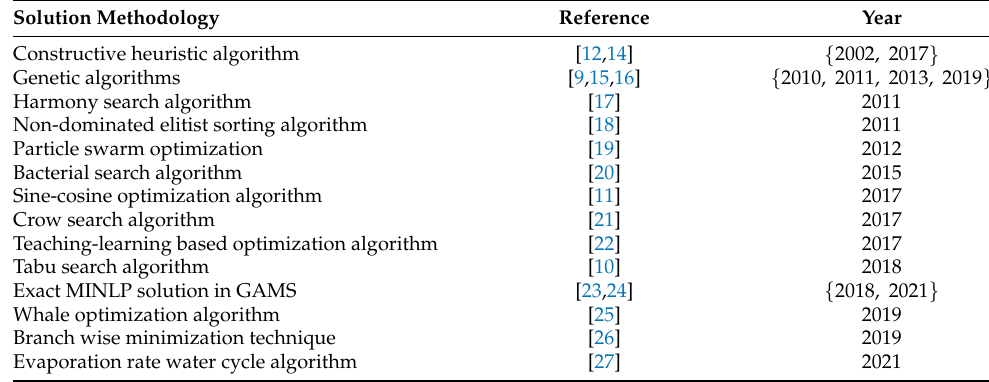
Table 1. Summary of methodologies used in the literature for optimal selection of calibers in distribution